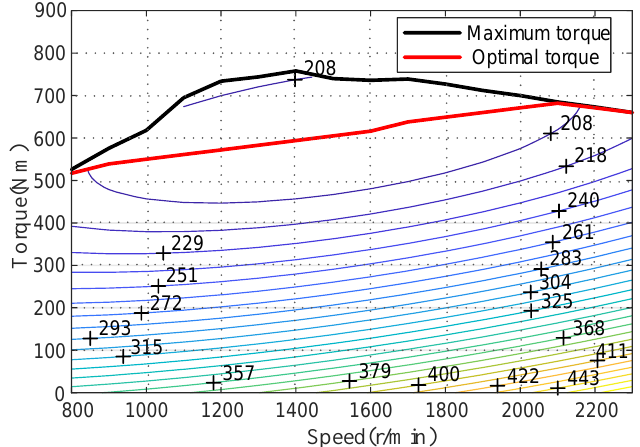
Figure 2. ICE efficiency map.